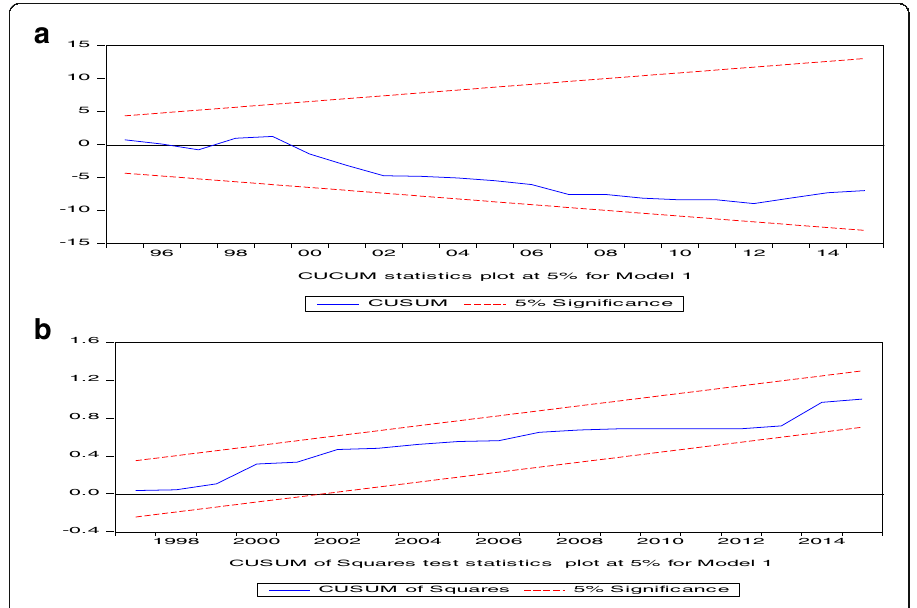
Fig. 2 a CUCUM statistics plot at 5% for Model 1. b CUSUM of Squares test statistics plot at 5% for Model